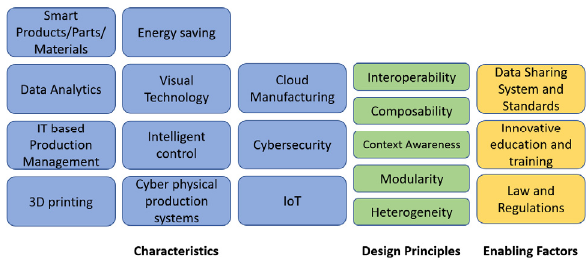
Figure 4. Logical components of Smart Manufacturing.